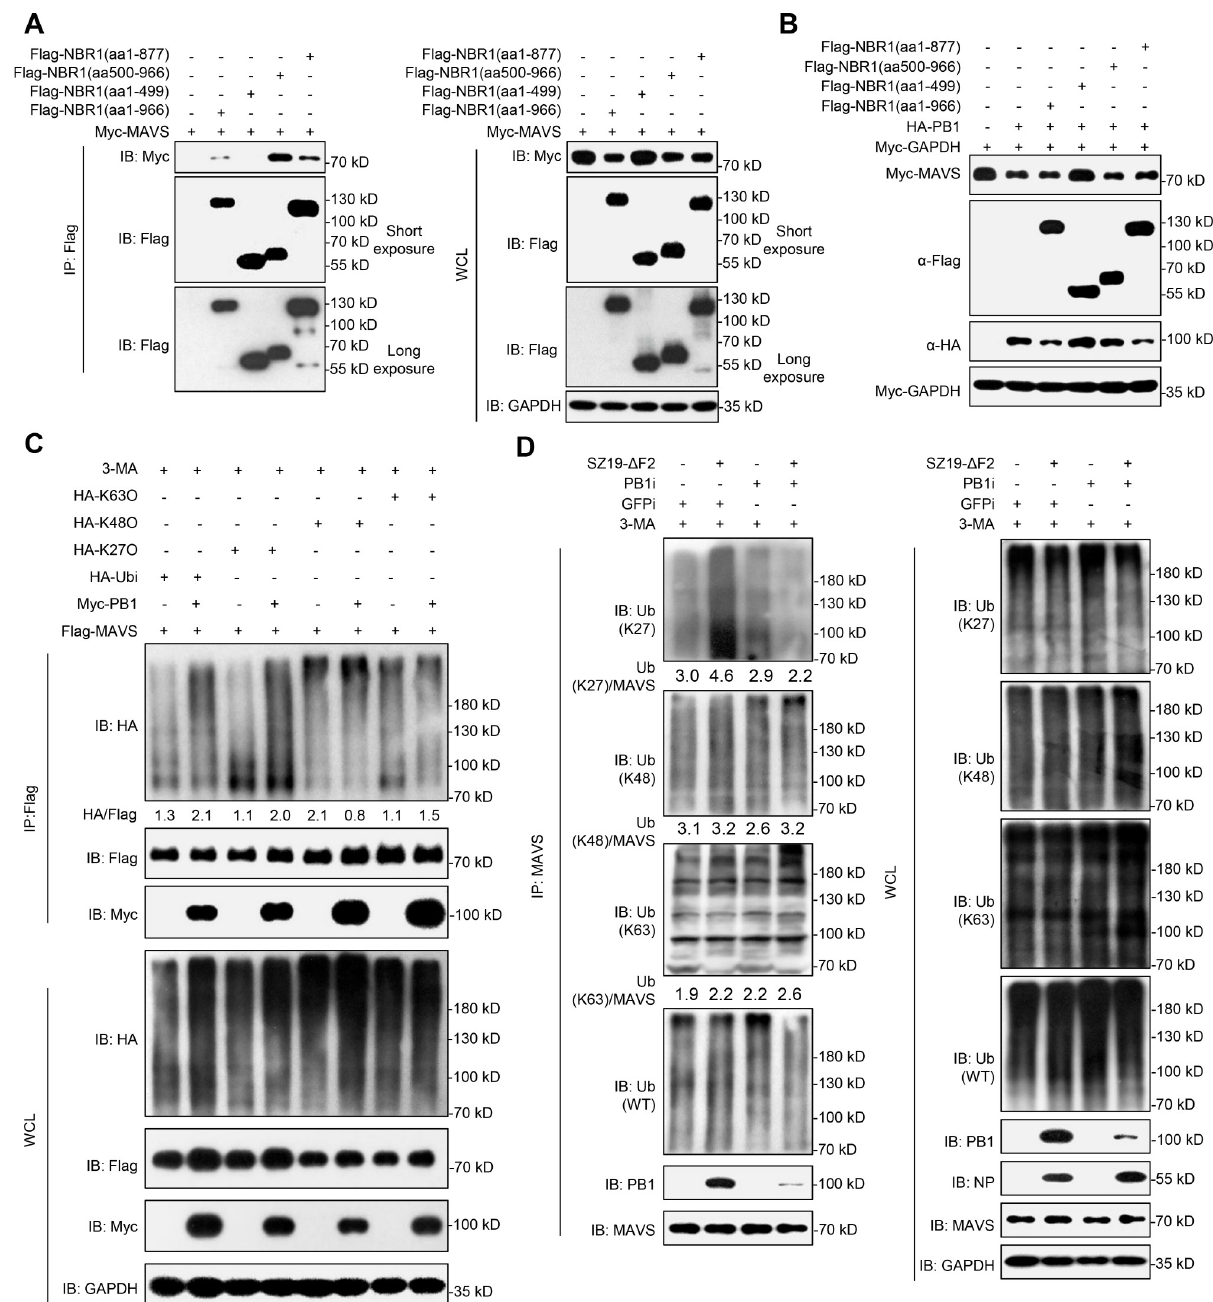
Fig 5. H7N9 PB1 promotes the K27-linked ubiquitination of MAVS. (A) MAVS interacts with NBR1. HEK293 cells were transfected with the indicated plasmids for 24 h. Then the co-immunoprecipitation and immunoblotting analysis were performed with the indicated antibodies. (B) NBR1 (aa500-966) is indispensable for MAVS degradation. HEK293 cells were transfected with HA-MAVS, Myc-PB1 and Flag-NBR1 with the indicated truncations for 24 h before immunoblot analysis with the indicated antibodies. (C) PB1 enhances K27-linked ubiquitination of MAVS. HEK293 cells transfected with Flag-MAVS, HA-ubiquitin, or its mutants [KO, which all but one lysine residues were simultaneously mutated to arginines (K-only)] together with a control and PB1 plasmids were pre-treated with 3-MA (10 mM) for 6h, the cells then were subjected to co-immunoprecipitation and immunoblotting analysis with the indicated antibodies. The intensities of the indicated protein bands were determined by using image J, were normalized to Flag-MAVS, and are shown as the fold-change of HA/Flag. (D) The effects of PB1-RNAi on SZ19- Δ F2 virus-triggered ubiquitination of endogenous MAVS. PB1-knockdown A549 cells were left uninfected or infected with SZ19- Δ F2 virus (MOI = 0.01) for 24 h. The cells then were treated with 3-MA for 6 h before ubiquitination assays with the indicated antibodies. The intensities of the indicated protein bands were determined by using image J, were normalized to MAVS, and are shown as the fold-change of the indicated Ub/MAVS. The data shown represent three independent experiments. https://doi.org/10.1371/journal.ppat.1009300.g005 PLOS Pathogens| https://doi.org/10.1371/journal.ppat.1009300 February 12,